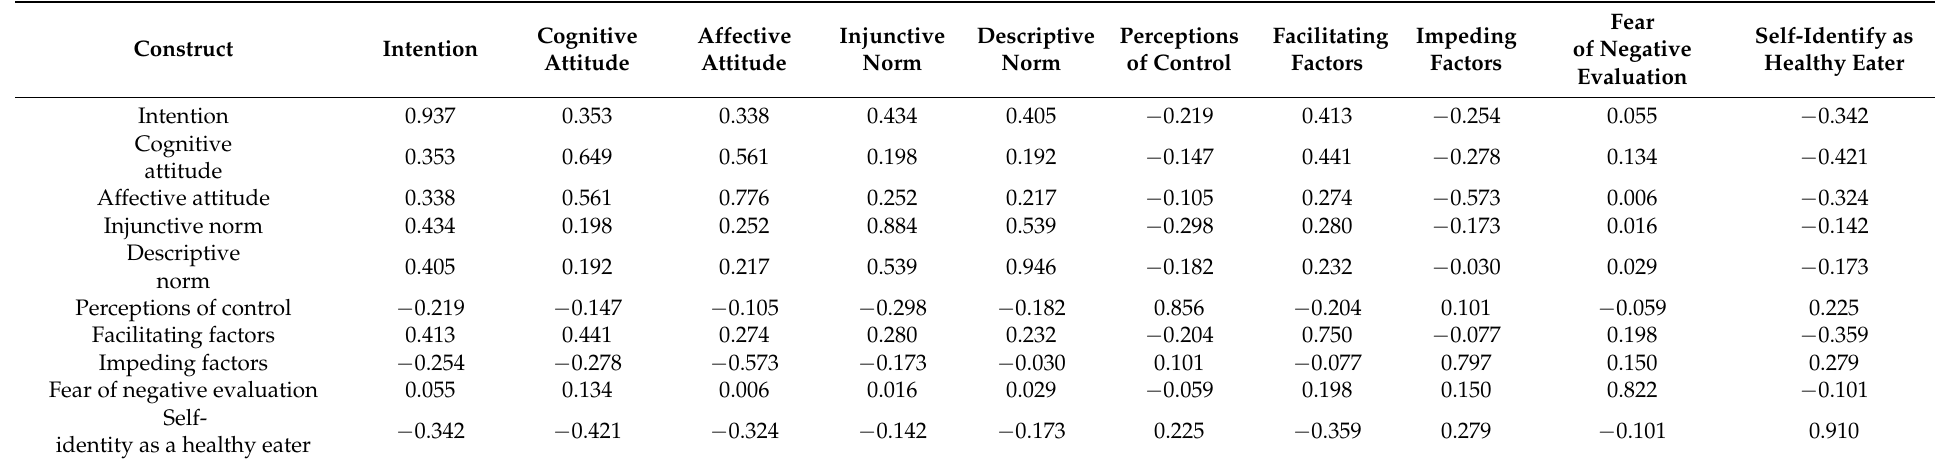
Table A2. Square roots of AVE.